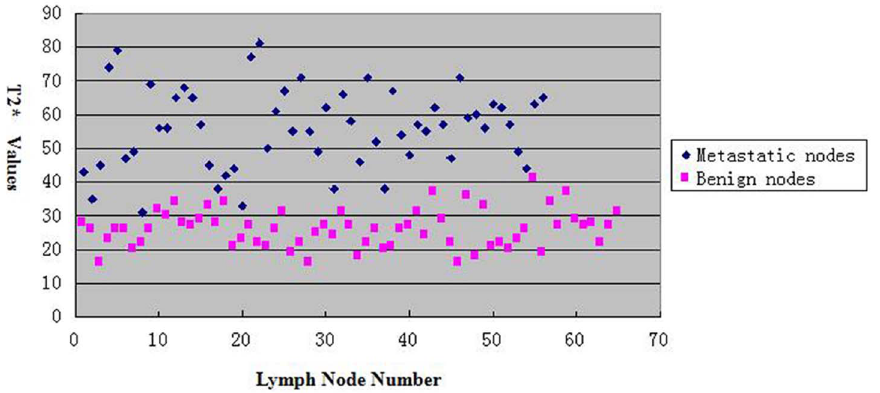
Figure 1. A plot of the T2* values of each metastatic and benign axillary lymph nodes. The horizontal axis indicates the lymph node number, and the vertical axis indicates the T2* values. Black rhombus represents metastatic nodes and red squares represent benign nodes, respectively.